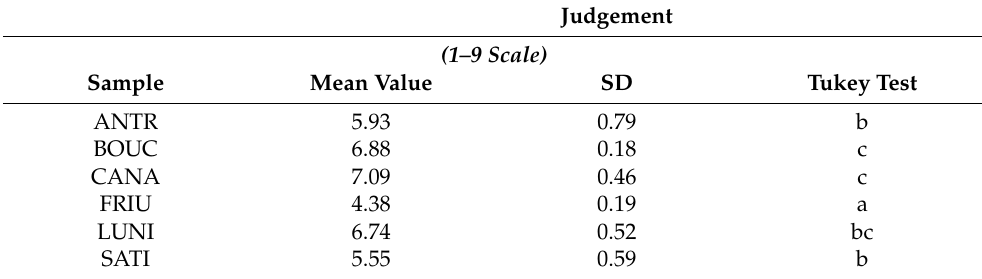
Table 4. Hedonistic profile of the cookies derived from the analysed chestnut